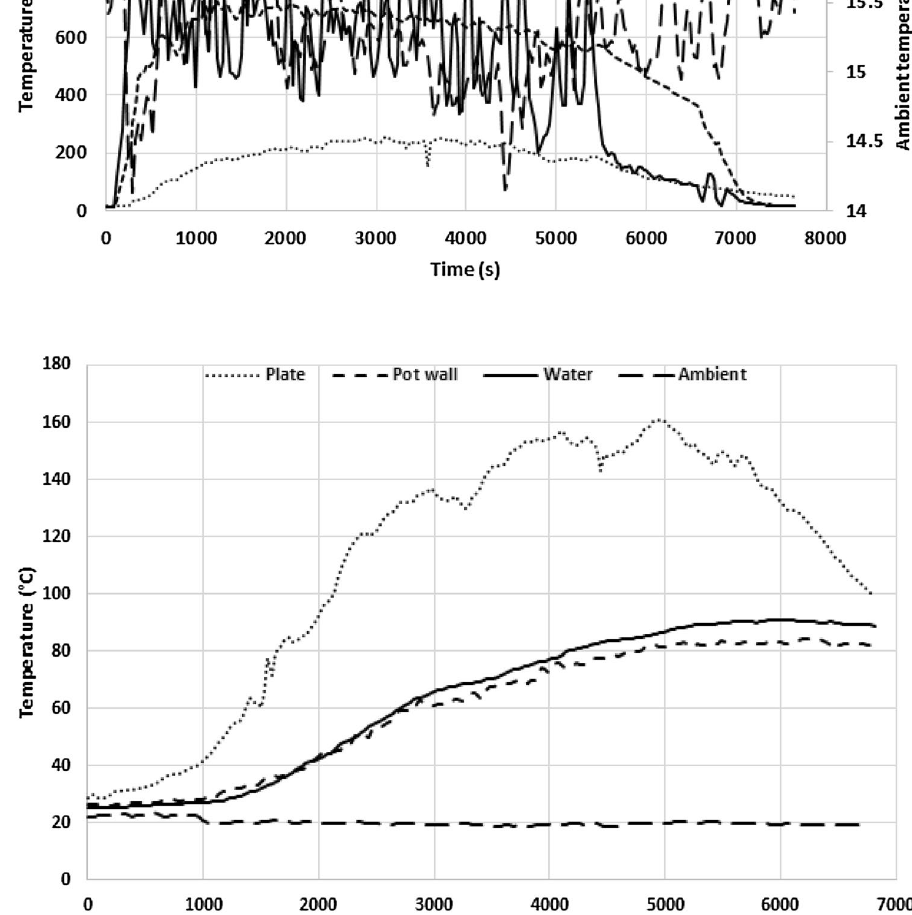
Fig. 3 Temperatures measured along a combustion test, with the plate configuration, on the ashtray (small hyphens), on the grid (solid line) and on the plate (dotted line), and ambient temperature (large hyphens, secondary axis)